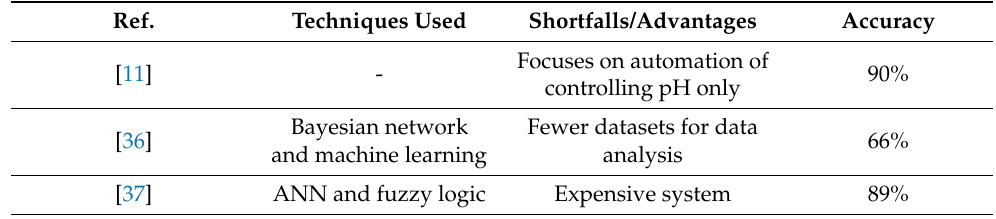
Table 5. Comparative analysis of various existing studies. Ref.